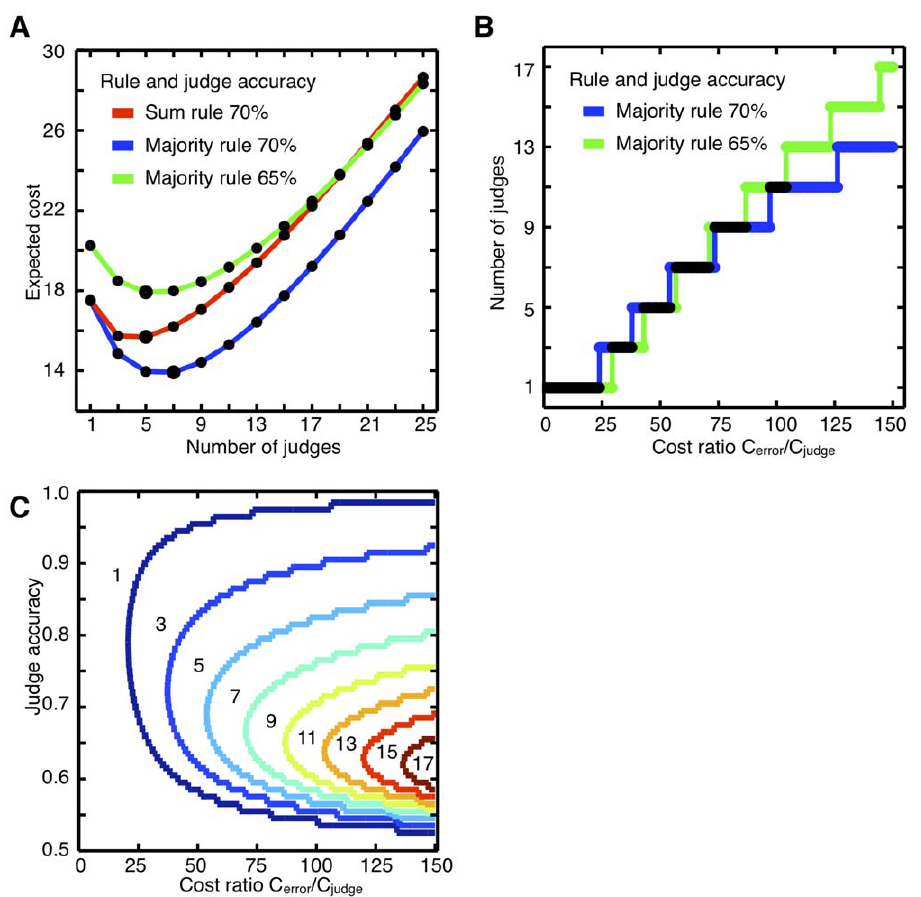
Figure 3. The paradox of the optimal number of judges. (A) The expected cost function (Equation 1) applied to the judge accuracy curve shown in Figure 2E. The cost per error is 55 times the cost per judge. The black line is the sum rule with 70% accurate judges, while the gray lines are majority rule (solid for 70% accurate judges and dashed for 65% accurate judges). The optimal number of judges, shown with the bigger dot, is different for the majority rule with 70% accurate judges. (B) The optimal number of judges as a function of the cost ratio. The majority rule with 70% accurate judges (red) and 65% accurate judges (blue) both increase the optimal number of judges as the cost ratio increases but diverge at points. (C) Contour plot of the optimal number of judges for majority rule as a function of the cost ratio and the judge accuracy. The reds indicate higher number of judges while the blues indicate lower numbers.